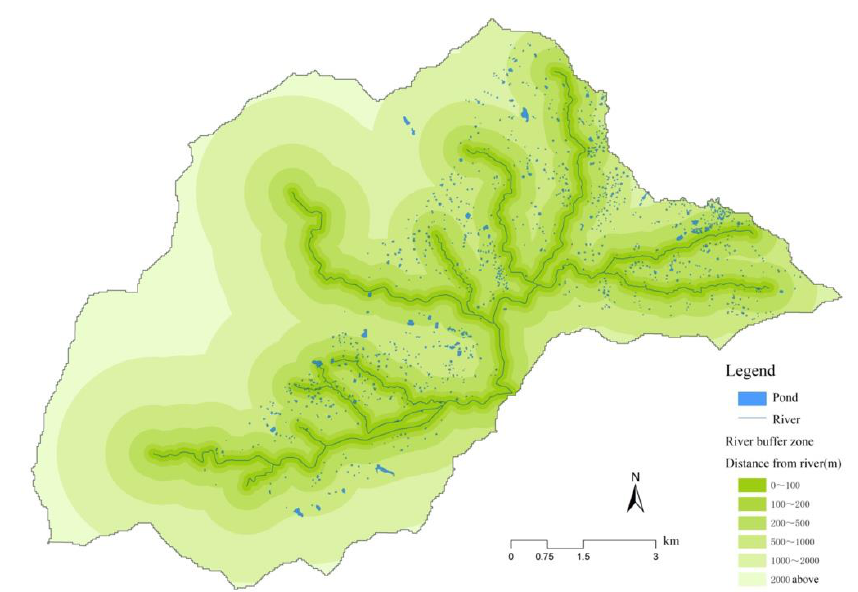
Figure 10. The river buffer dataset.